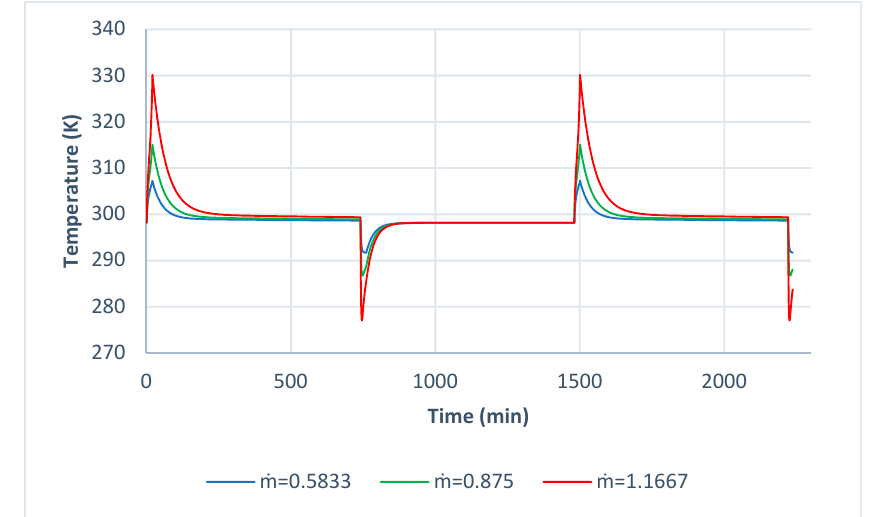
Figure 5. Gas temperature trend for the Second Configuration varying the liquid flow rate.